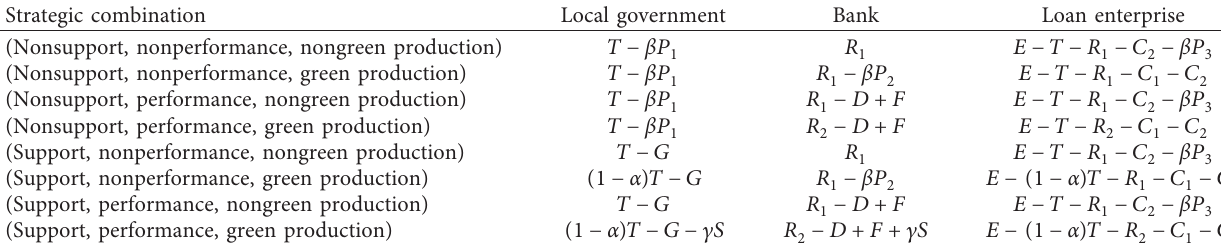
Table 1: Payoff matrix of local government, bank, and loan